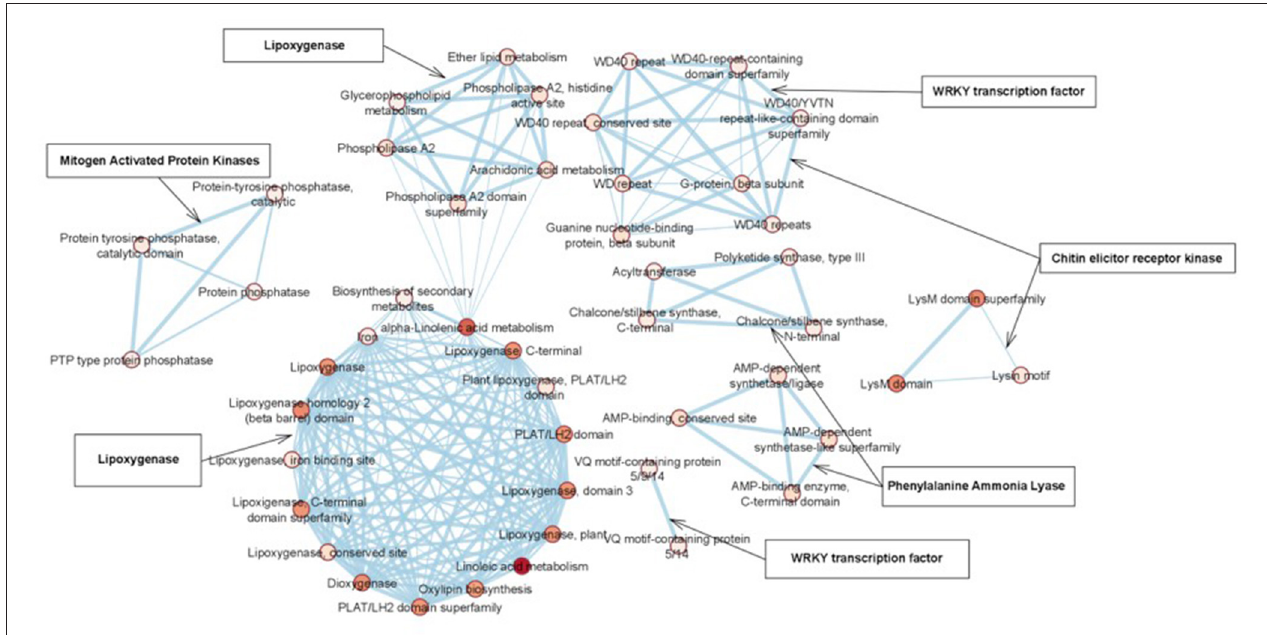
FIGURE 7 | Functional enrichment analysis of defense genes in biohardened Karpooravalli (ABB) banana